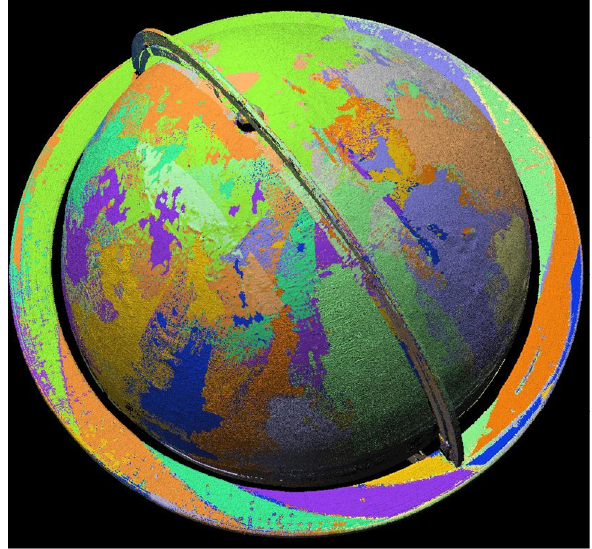
Fig. 5: Registered range-based point clouds of the Behaim